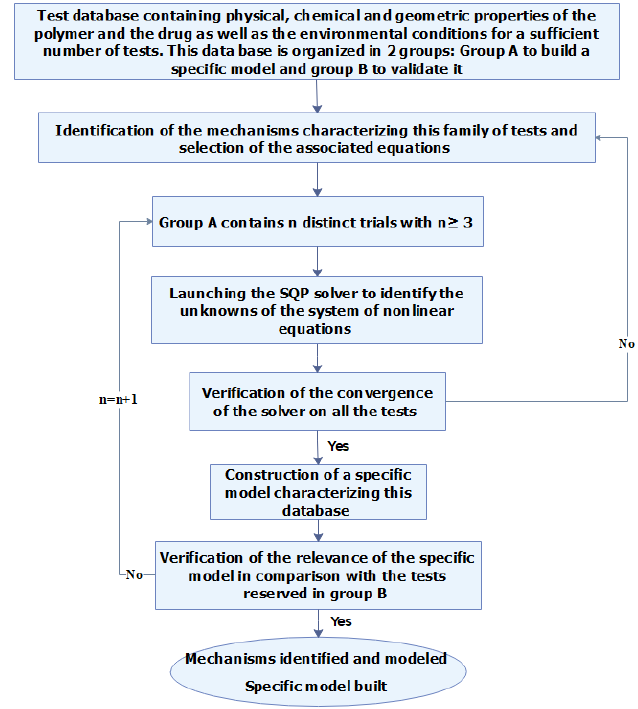
Figure 1. Flowchart of the proposed method.